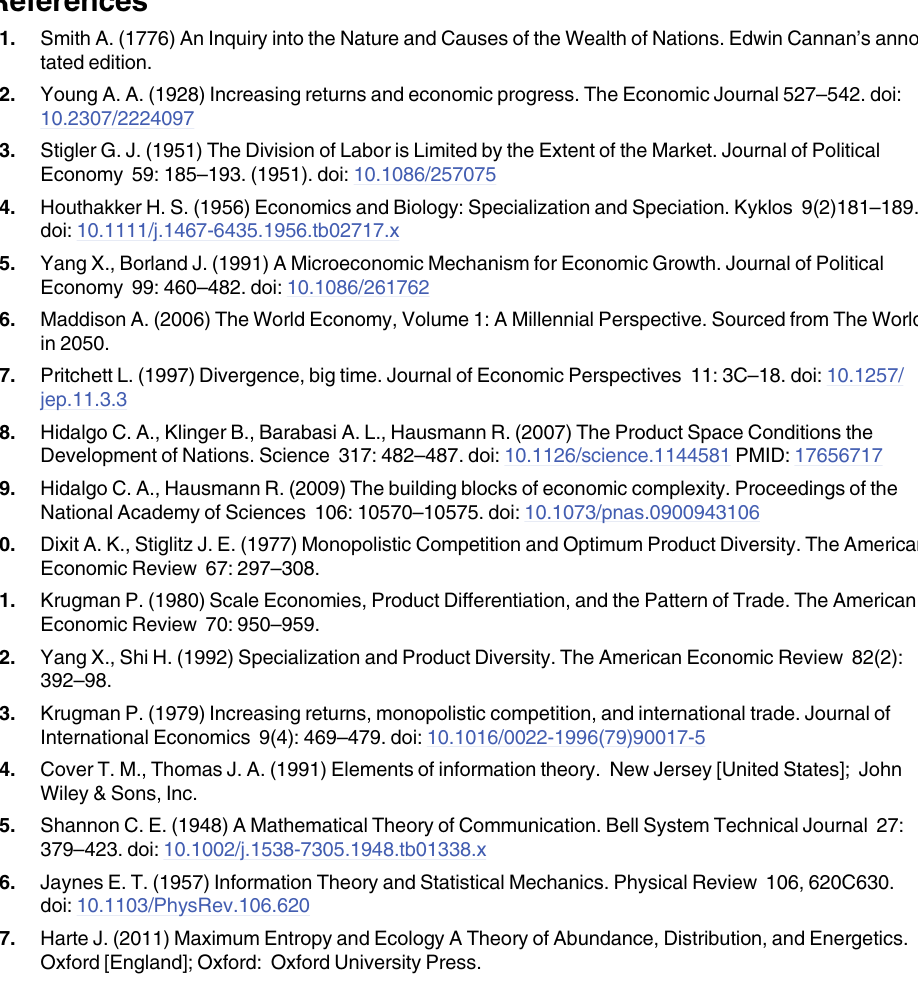
Figure B . Top Gabon Exports in